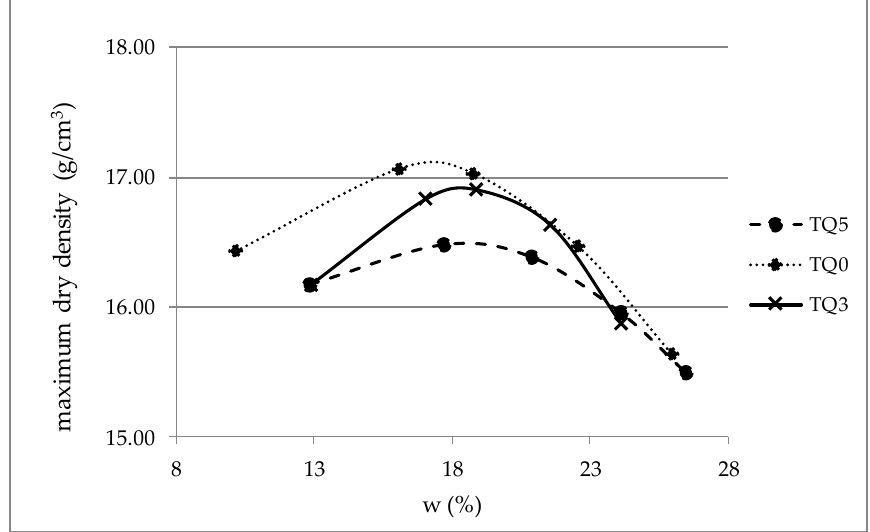
Figure 1. Comparison of compaction curves.